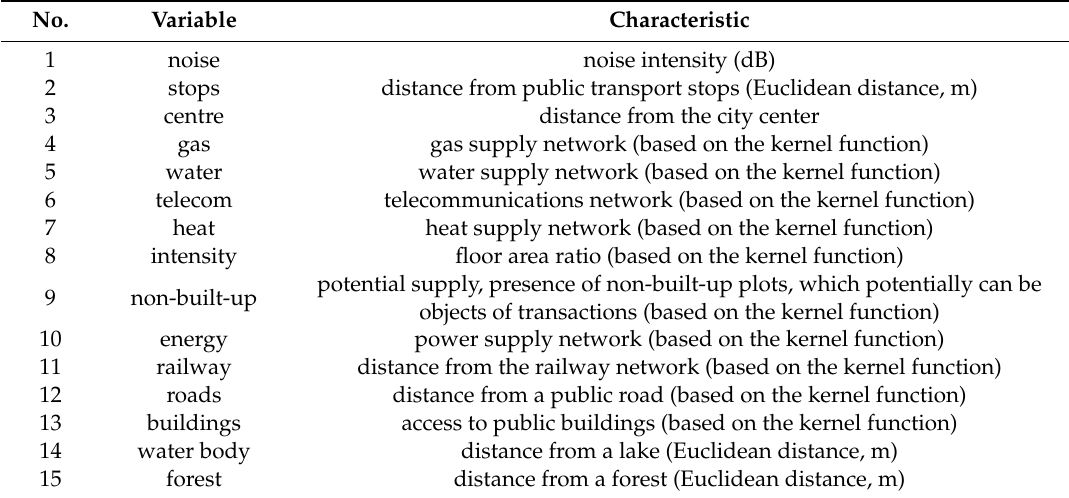
Table 1. List of variables taken for